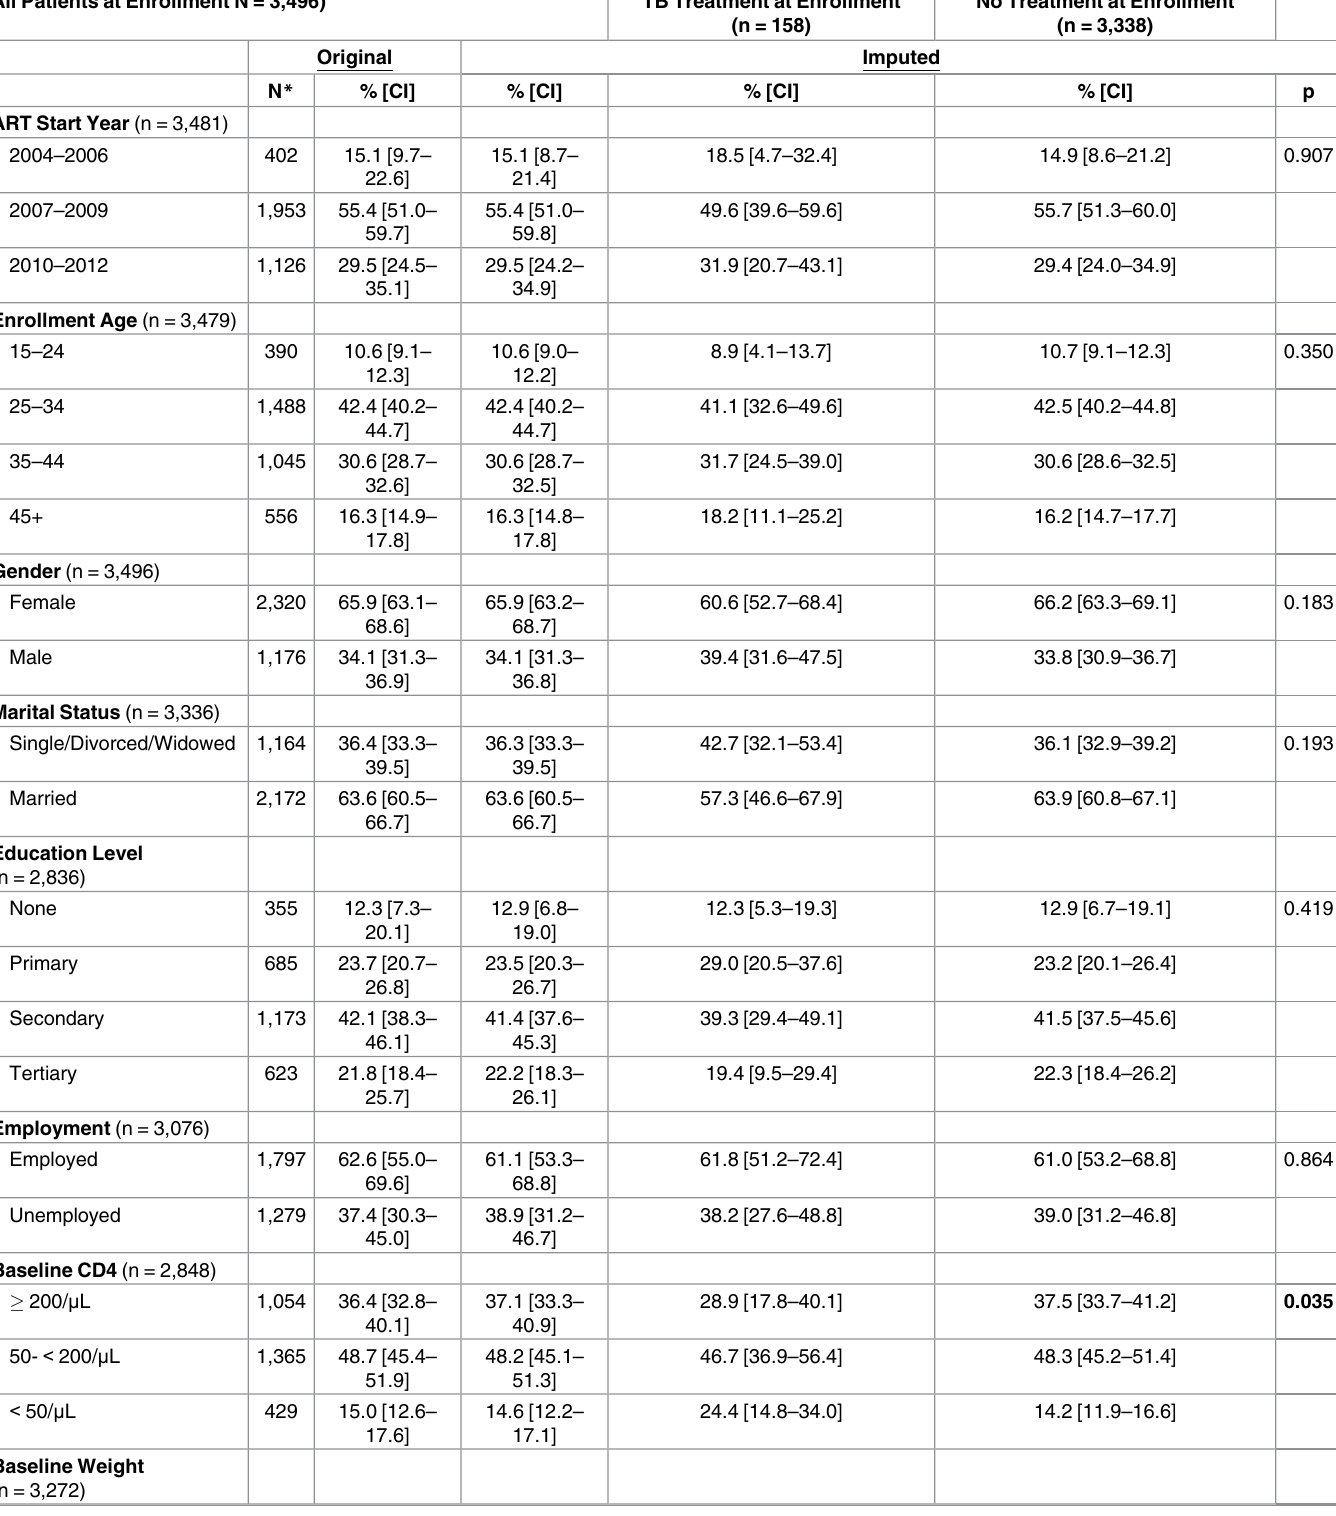
Table 1. Patient Characteristics, by Known Prevalence of Active TB at ART Initiation. All Patients at Enrollment N =